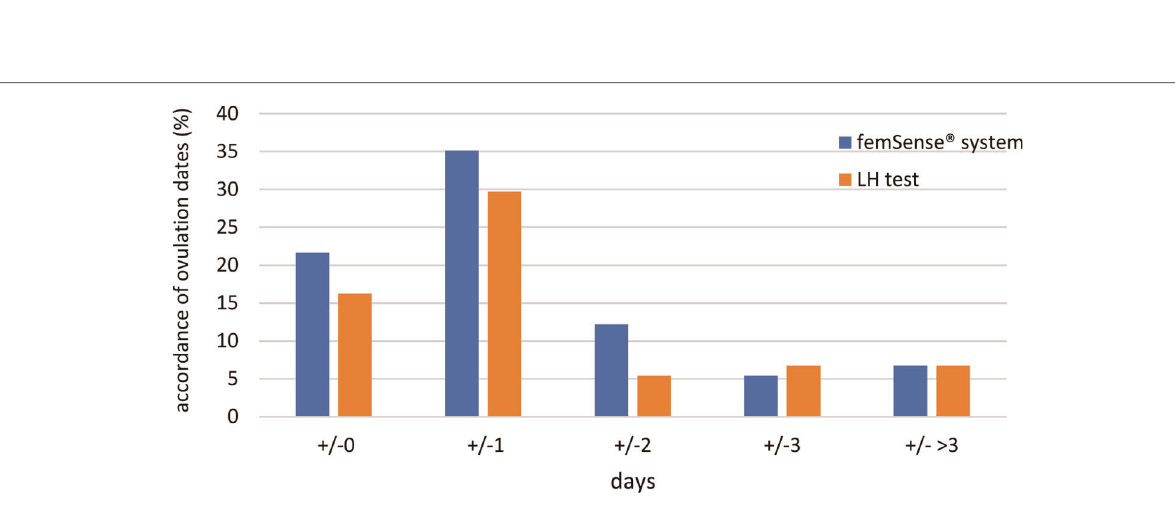
FIGURE 4 Accordance of ovulation days of femSense ® system and LH test compared to ultrasound: An exact accordance of the patch was found in 16 participants (21.7%), a difference of one day in 26 participants (35.1%), a difference of two days in 9 participants (12.2%), a difference of three days in 4 participants (5.4%) and a difference of more than three days in 5 participants (6.8%). An exact accordance of the LH test was found in 12 participants (16.2%), a difference of one day in 22 participants (29.7%), a difference of two days in 4 participants (5.4%), a difference of three days in 5 participants (6.8%) and a difference of more than three days in 5 participants